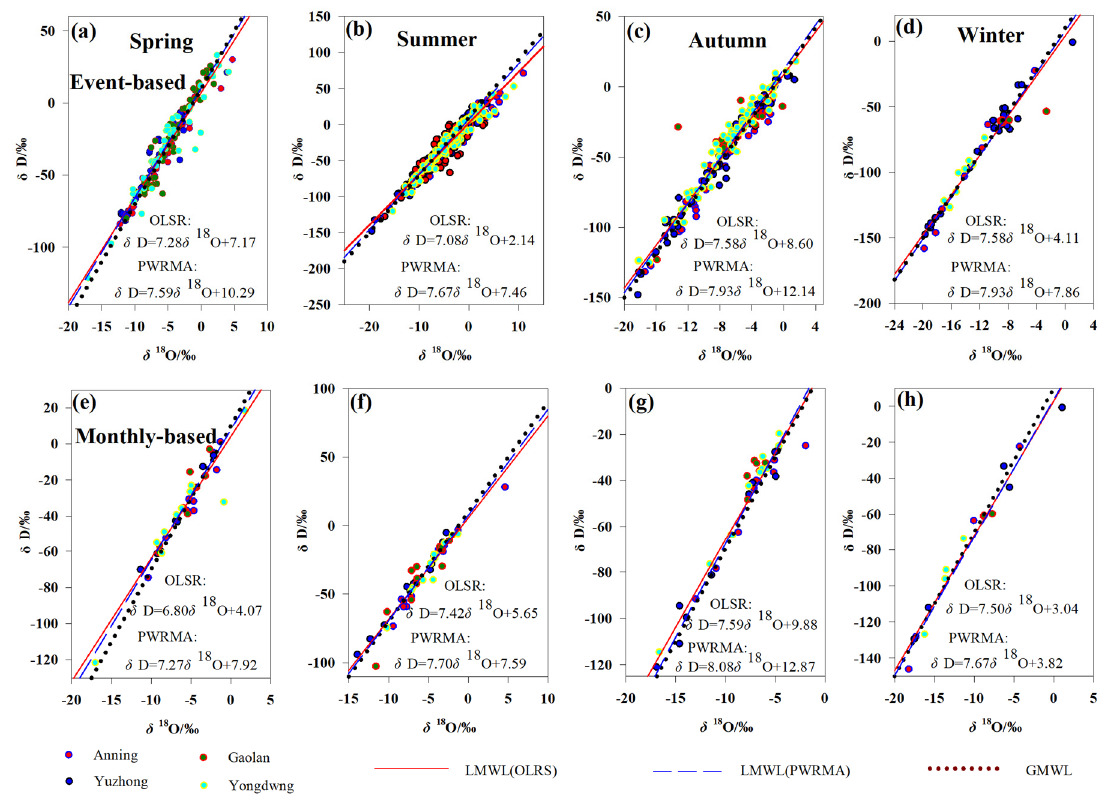
Figure 4. Linear relationship between δ D and δ 18 O using event-based ( a – d ) and monthly data ( e – h ) on a seasonal basis for all sampling stations in Lanzhou from 2011 to 2014. OLSR-based and PWRMA-based LMWLs as well as GMWL ( δ D = 8 δ 18 O + 10; [4]) are shown.